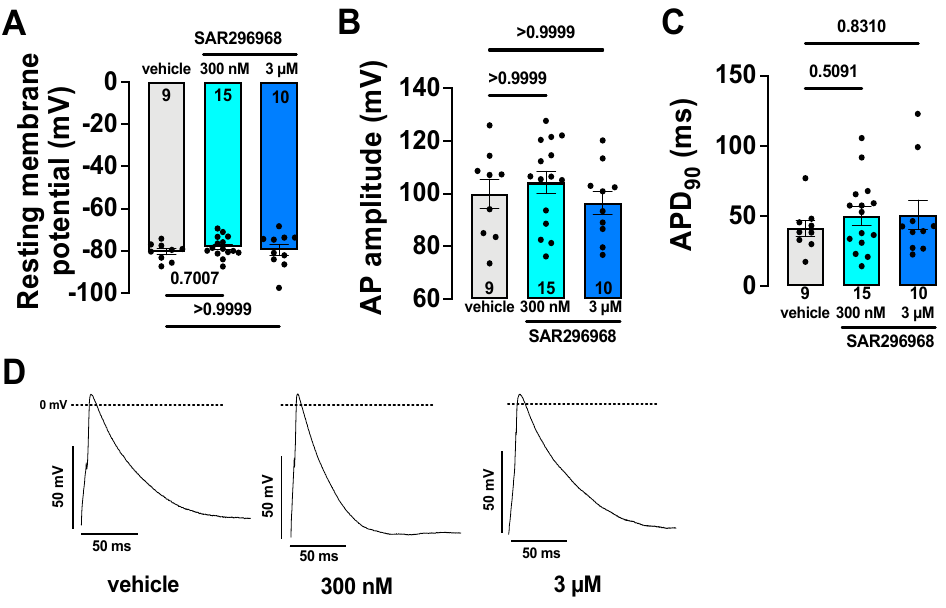
Figure 3. The numbers indicated are numbers of patients. The data points represent individual patients. Each data point was calculated as the mean from several cells within each patient. The mean data per patient for action potential characteristics were measured in isolated human atrial myocytes by the whole-cell patch clamp technique. ( A ) resting membrane potential, ( B ) AP amplitude, and ( C ) action potential duration (APD) at 90% of maximum repolarization were unaffected by SAR296968. The original traces are shown in ( D ). The p -values are denoted above the corresponding groups, RM-mixed effects analysis with Bonferroni post-hoc test.